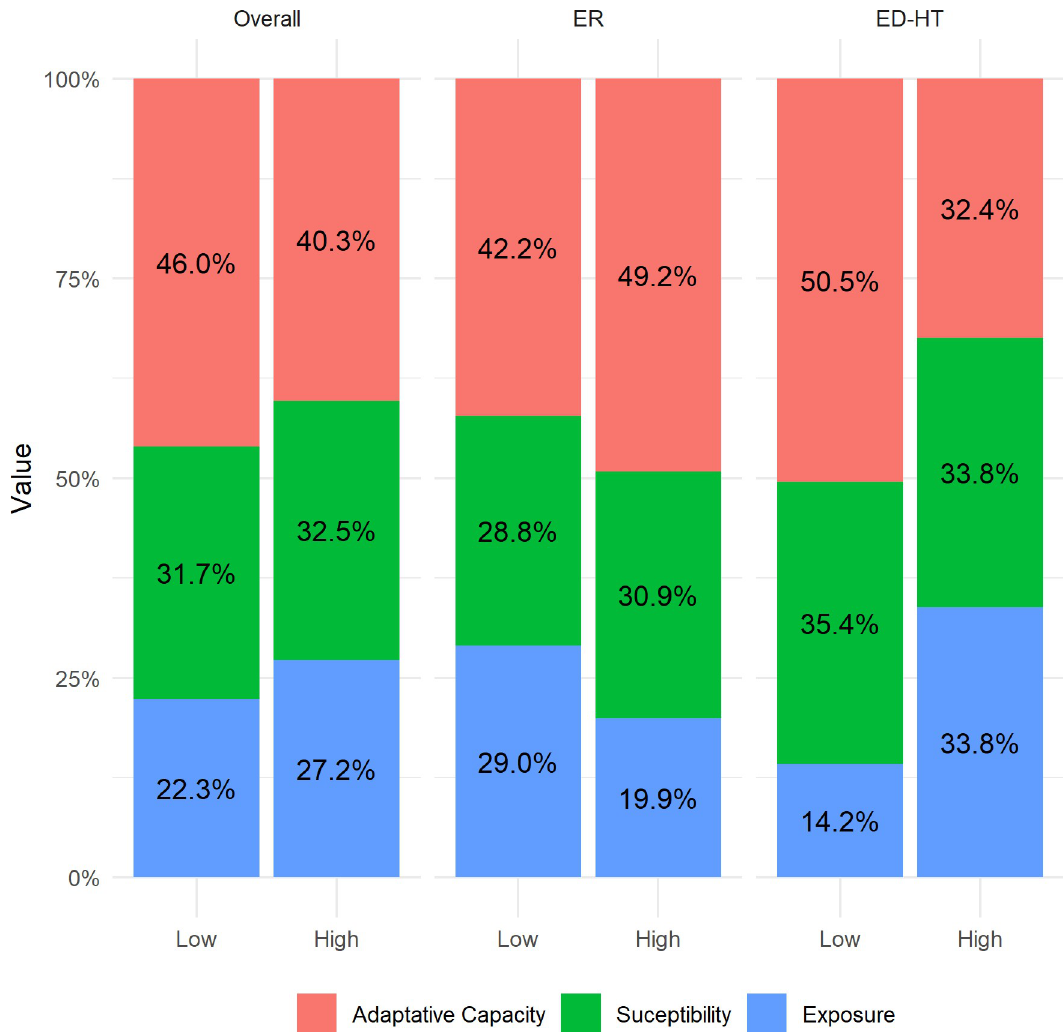
Fig 3. Decomposition analysis of the ECVI for the overall and homoclimatic regions according to the level of climate-sensitive diseases (k = 0.25). ER: Extreme rain zones in the Brazilian Amazon and Northeast region; ED-HT: Extreme drought and high temperature in the Brazilian Amazon and Northeast region; ECVI: Extreme Climate Vulnerability